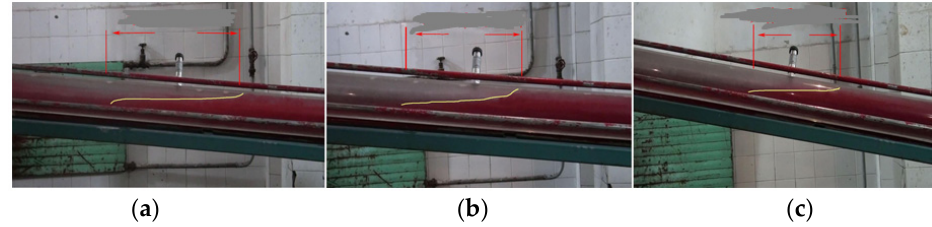
Figure 4. The influence of a deviated angle on a cementing displacement interface (The range indi ‐ cated by the arrow denotes the range of displacement interface). ( a ) well deviation angle = 85°; ( b ) well deviation angle = 83°; ( c ) well deviation angle = 80°.